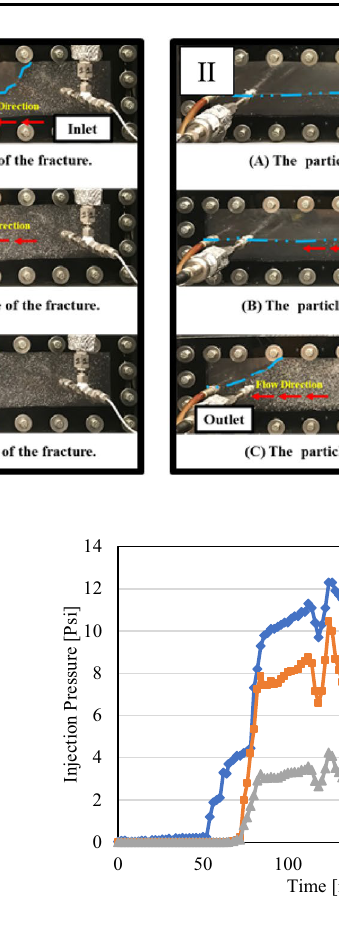
Fig. 9 Gel propagation injection pressure though fractures 6.75 mm using 1450 pa strength (gel particle size to fracture width ratio is